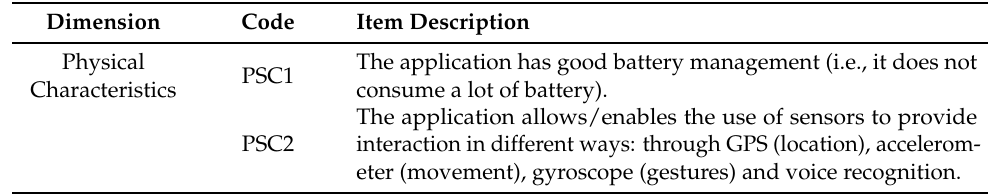
Table 6. The Physical Characteristics dimension and its items.